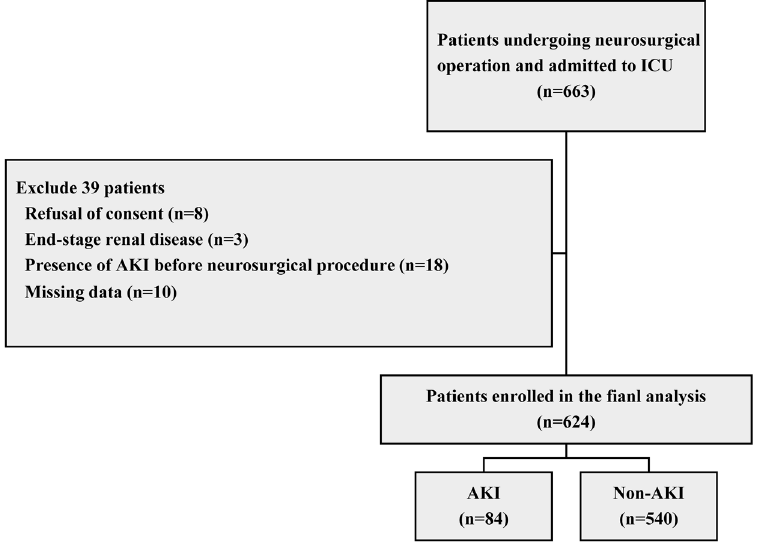
Figure 1. Flow chart from recruitment to outcome. Abbreviations: ICU, intensive care unit; AKI, acute kidney